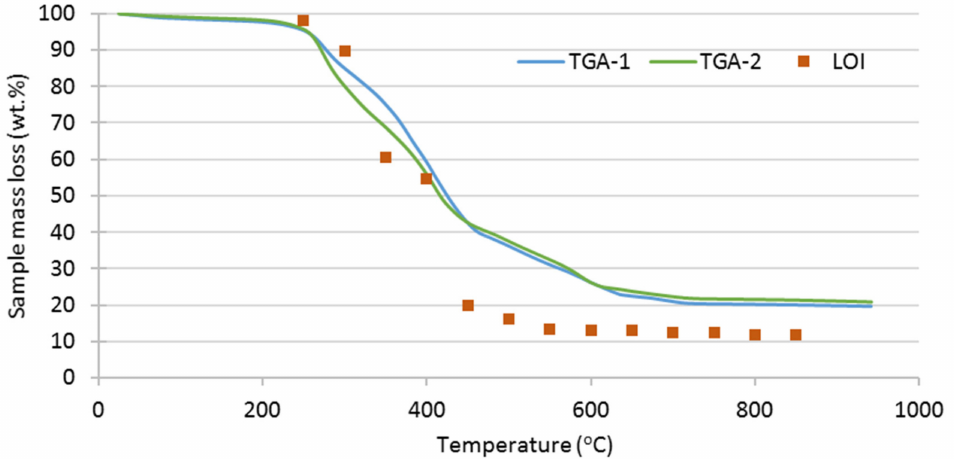
Figure 2. Compared thermal degradation of SRF (sample mass loss) in air and 10 ◦ C/min obtained by thermogravimetric analysis and LOI measurement in a muffle